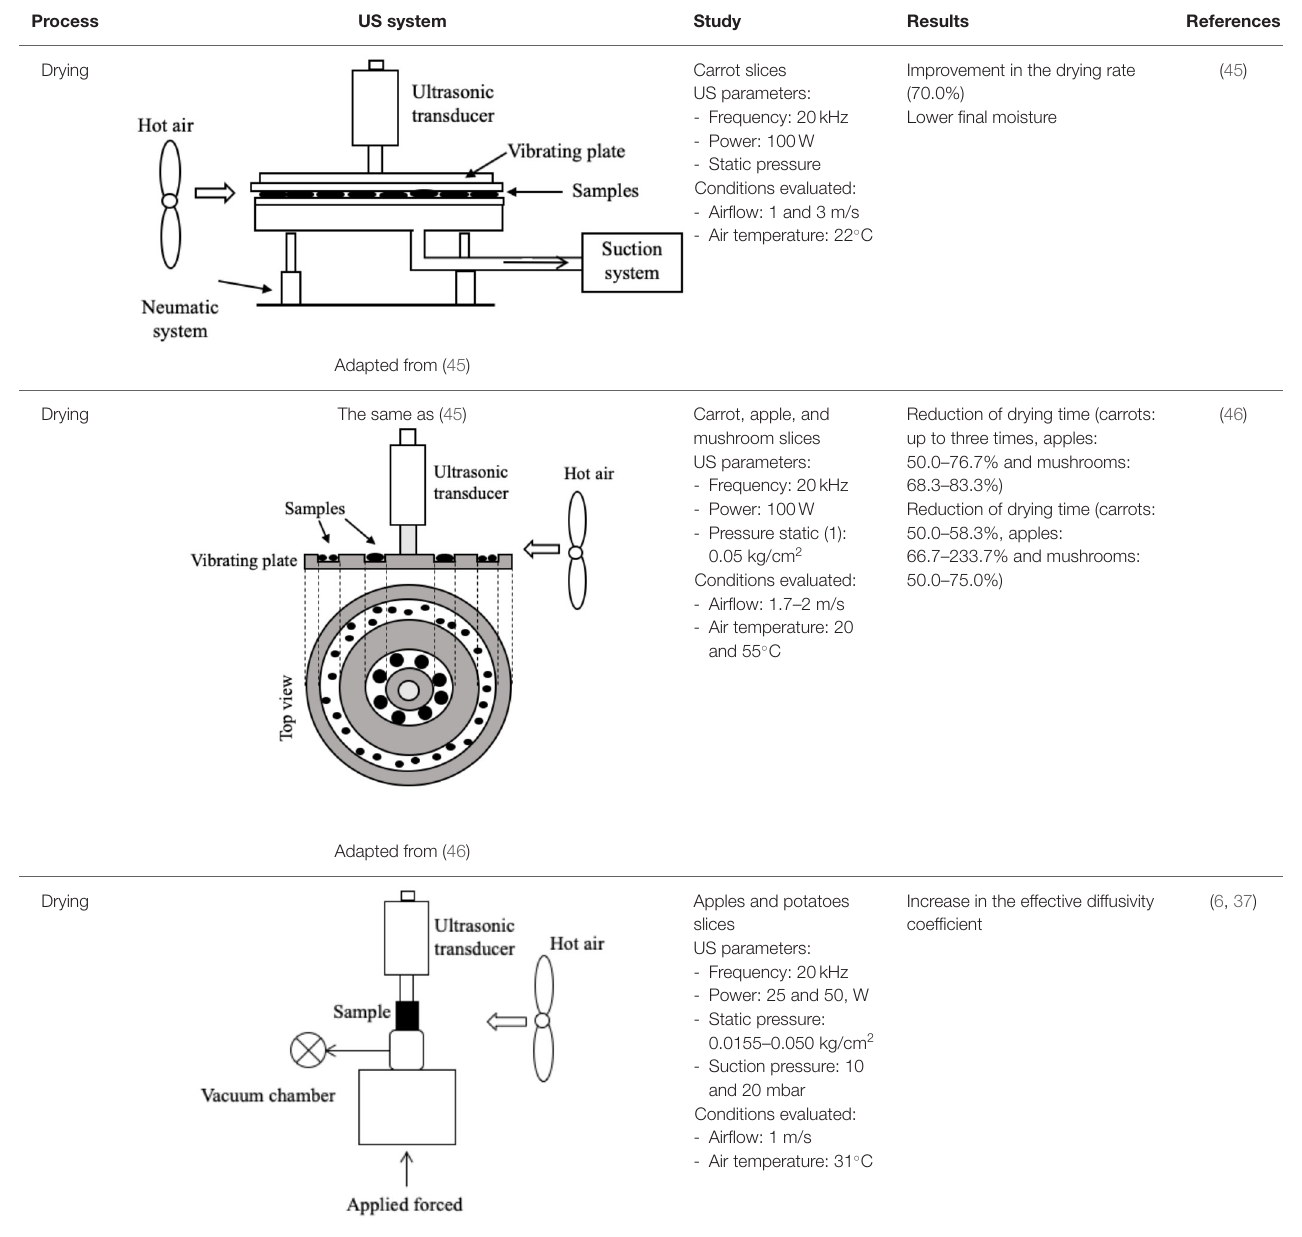
TABLE 1 | Different systems of application of US by direct contact with food.